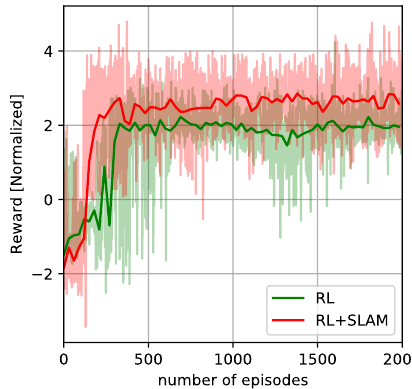
Figure 4. Normalized reward per episode for the trained agent (Target 1). The proposed reward function (red) guarantees drastically improved the convergence rate with respect to a reward function that doesn’t use the knowledge of the map (green). Notice that because the reward functions are different, the median value of the reward is not taken into account when making the comparison.